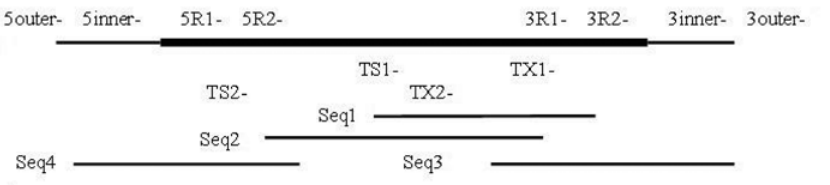
Fig.1. cloning strategy and map of the primers for amplifying the full sequence of the PvtH gene; ts1 and tX1 for seq 1 of 739bp; ts2 and tX2 for seq 2 of 860bp; 3r1 and 3r2 for seq 3 of 710bp; 5r1 and 5r2 for seq 4 of